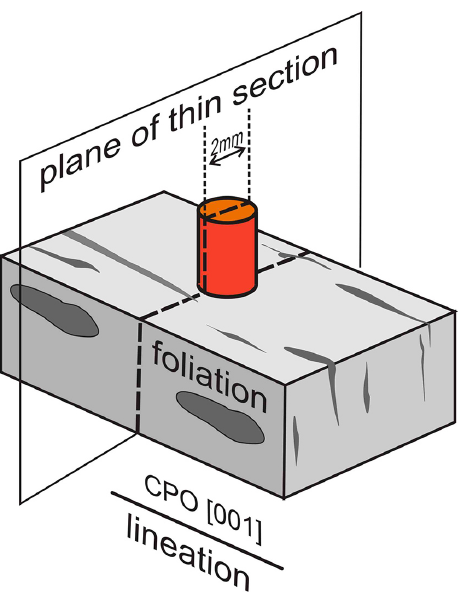
Figure 4. Scheme of creep rig. Panel (a) – conventional configura- tion with a cylindrical sample. Panel (b) – configuration used in in- dentation creep experiments with a small cylindrical indenter thrust into a plane-parallel plate of sample material. Apart from sample assembly, the entire set-up is identical for both approaches.